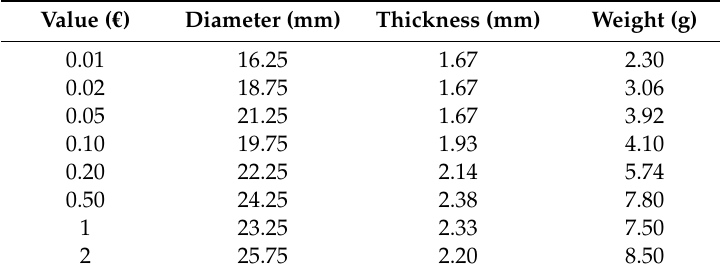
Table 1. Features of the Euro Coins.